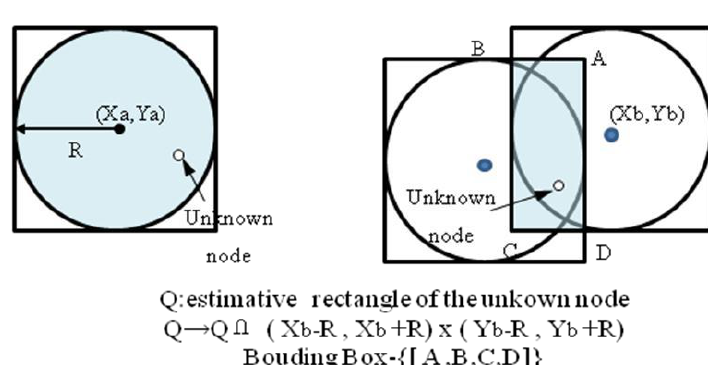
Figure 1. Bounding Box